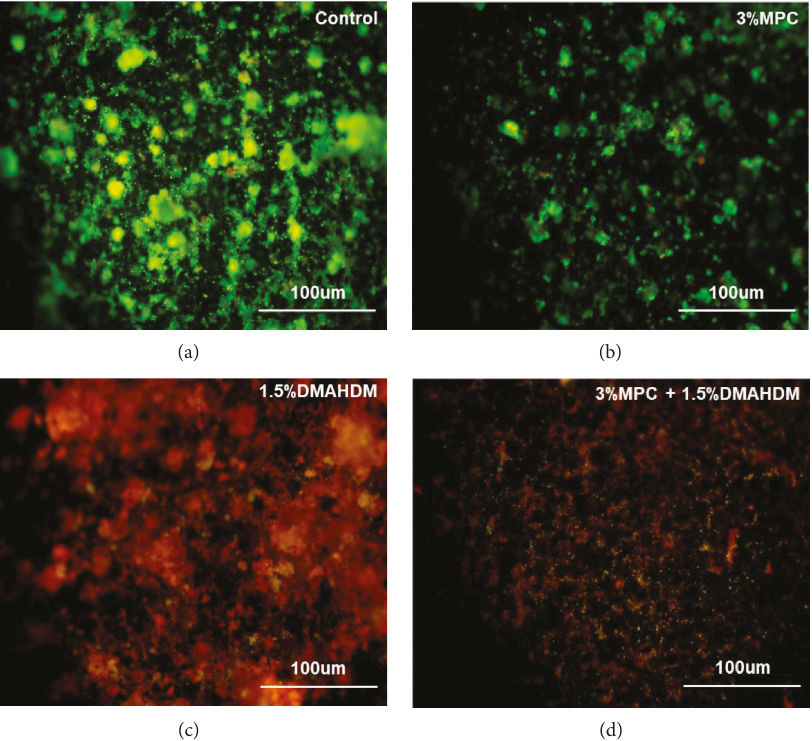
Figure 7: Representative live/dead staining images of bio fi lms adherent on PMMA discs cultured for 2 days: (a) control group, (b) 3% MPC group, (c) 1.5% DMAHDM group, and (d) 3% MPC+1.5% DMAHDM group. The live bacteria were stained green, and the dead bacteria were stained red. When live and dead bacteria were in close proximity or on the top of each other, the staining had yellow or orange colors. (Adapted from reference [75], with